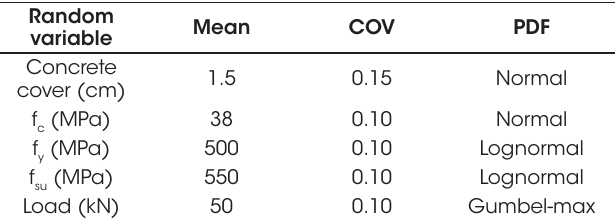
Random variables for simple supported RC beam